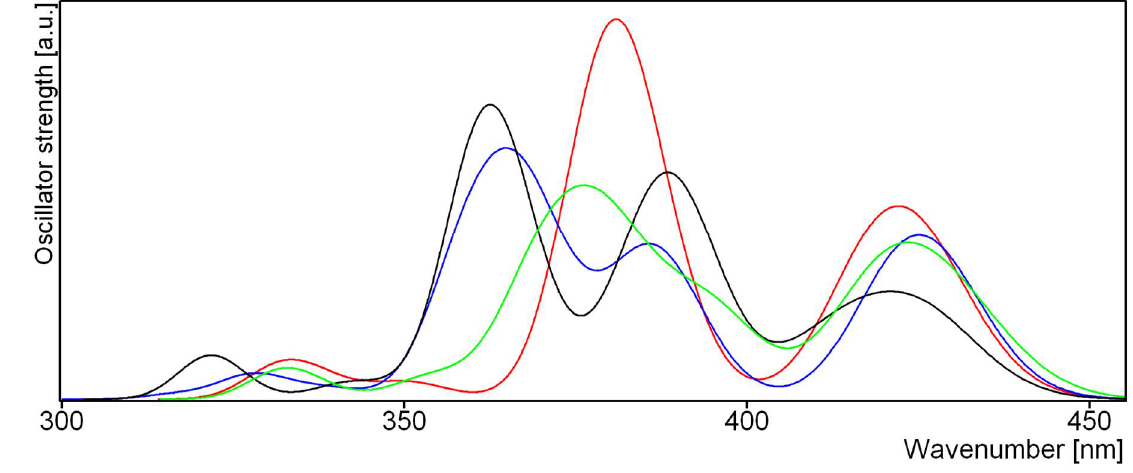
Figure 11. Theoretical excitation spectra for sennidin derivatives 1—red, 7—green, 11—blue and 17—black.